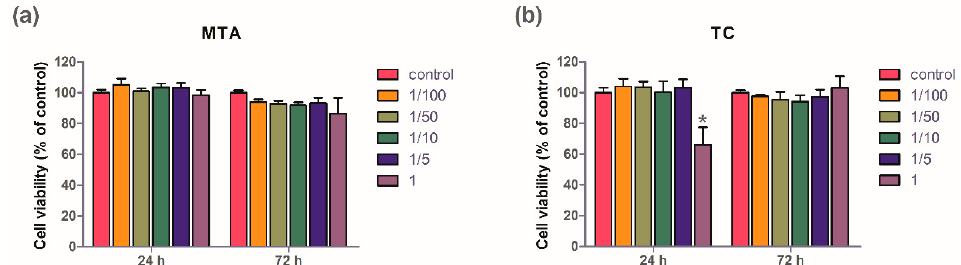
Figure 1. Water-soluble tetrazolium salt (WST) assay of mineral trioxide (MTA) and TheraCal LC (TC). The cell viability under different conditions was evaluated using the WST assay. The results are shown as the ratio of optical density at 450 nm of culture medium from cells exposed to pulp capping materials compared to control cell culture medium. ( a ) Cell viability of MTA under different concentrations. ( b ) Cell viability of TC under different concentrations. The cell viability significantly decreased when the cells were exposed to TC at a concentration of 100% for 24 h. * p < 0.05.